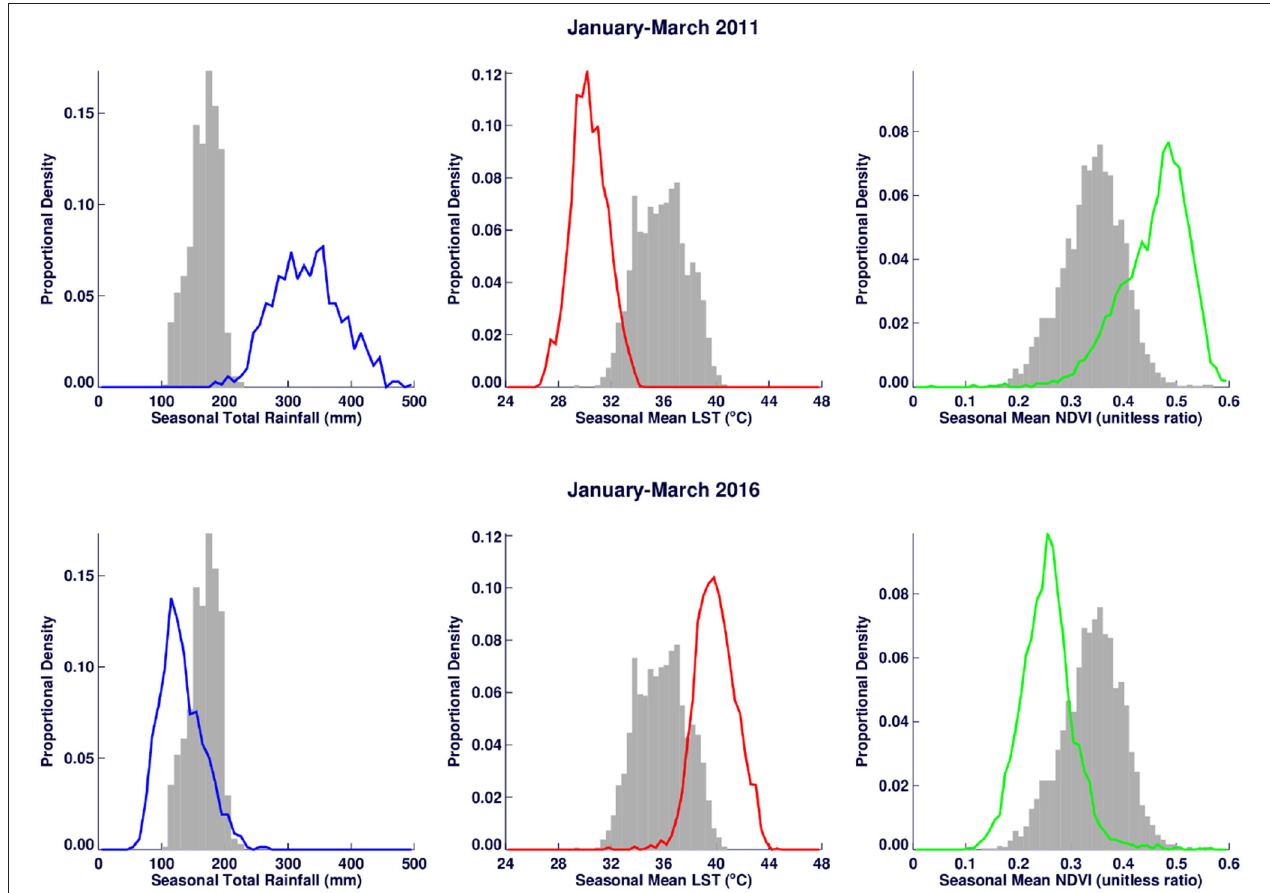
FIGURE 9 | Climate variable distribution comparisons between Rift Valley fever epizootic period (January–March 2011) ( top ) and post-epizootic period (January–March 2016) illustrates clear shift to the right of the long-term mean distribution (in rainfall and normalized difference vegetation index) and to left (land surface temperature) during the epizootic period. The distribution shifts are reversed during the interepizootic period. The gray bars represent the long-term mean distribution for each